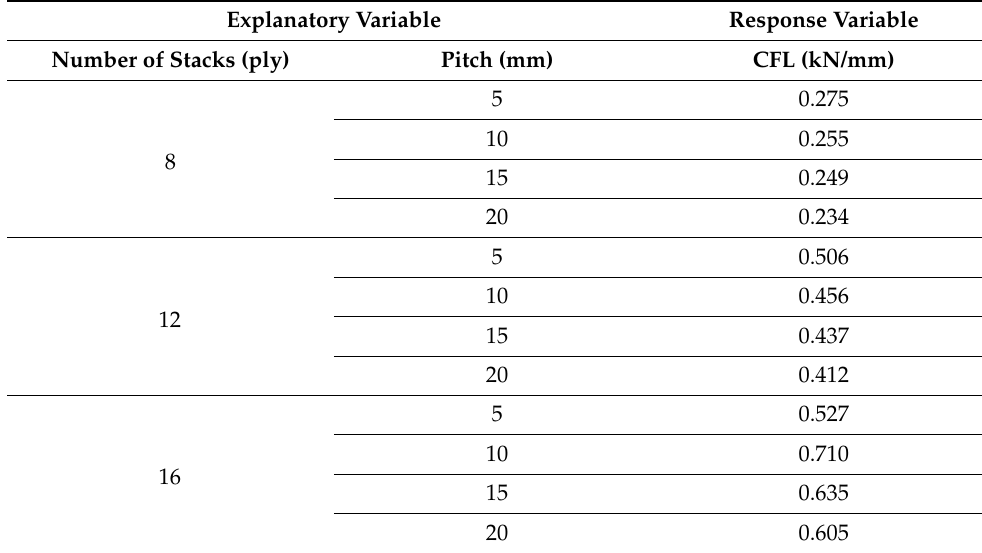
Table 6. Explanatory variable and response variable (CFL).